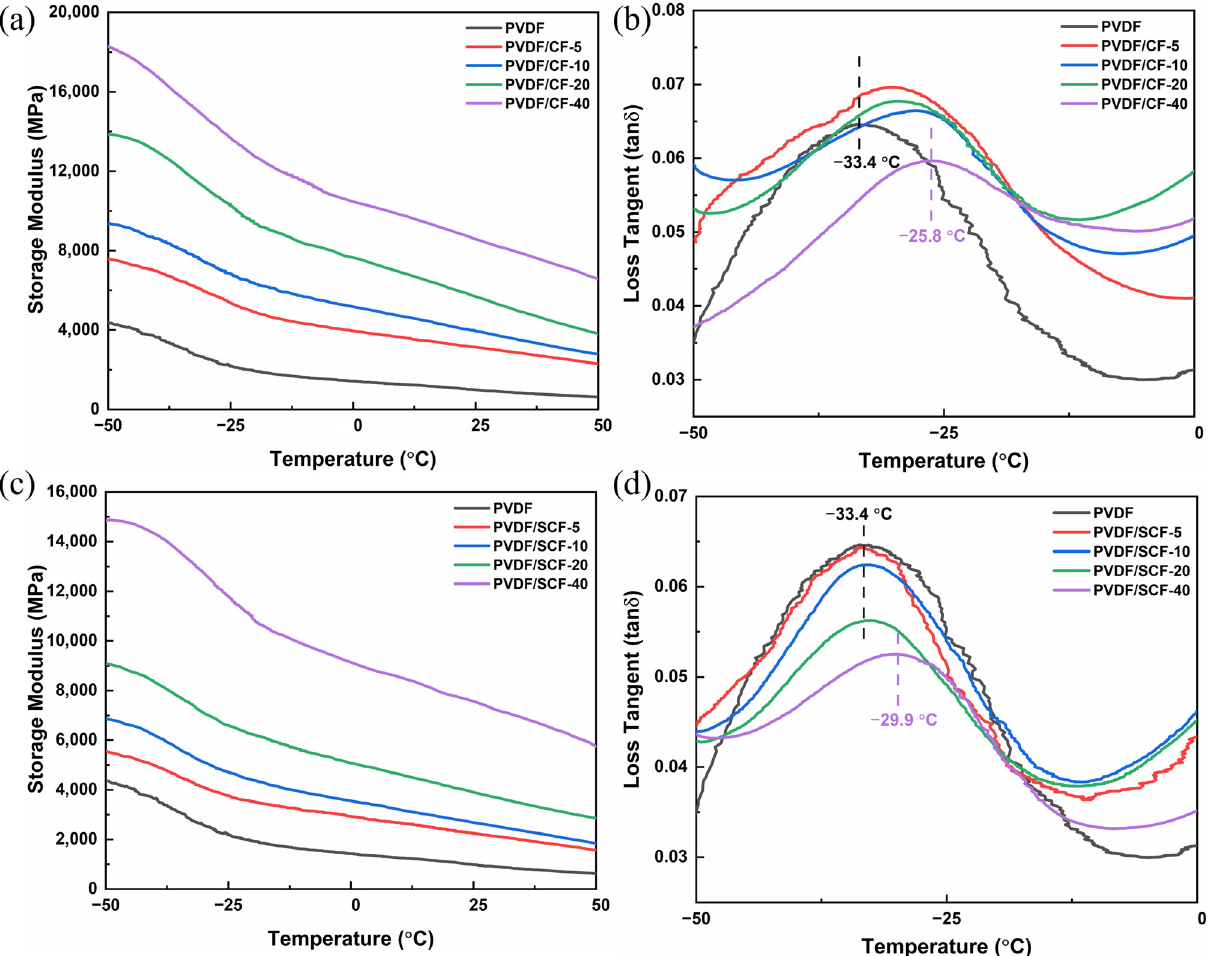
Figure 9. DMA test results of pure PVDF and PVDF composites ( a , c ): energy storage modulus of PVDF/CF and PVDF/SCF composite series, ( b , d ): loss factor of PVDF/CF and PVDF/SCF composite series.